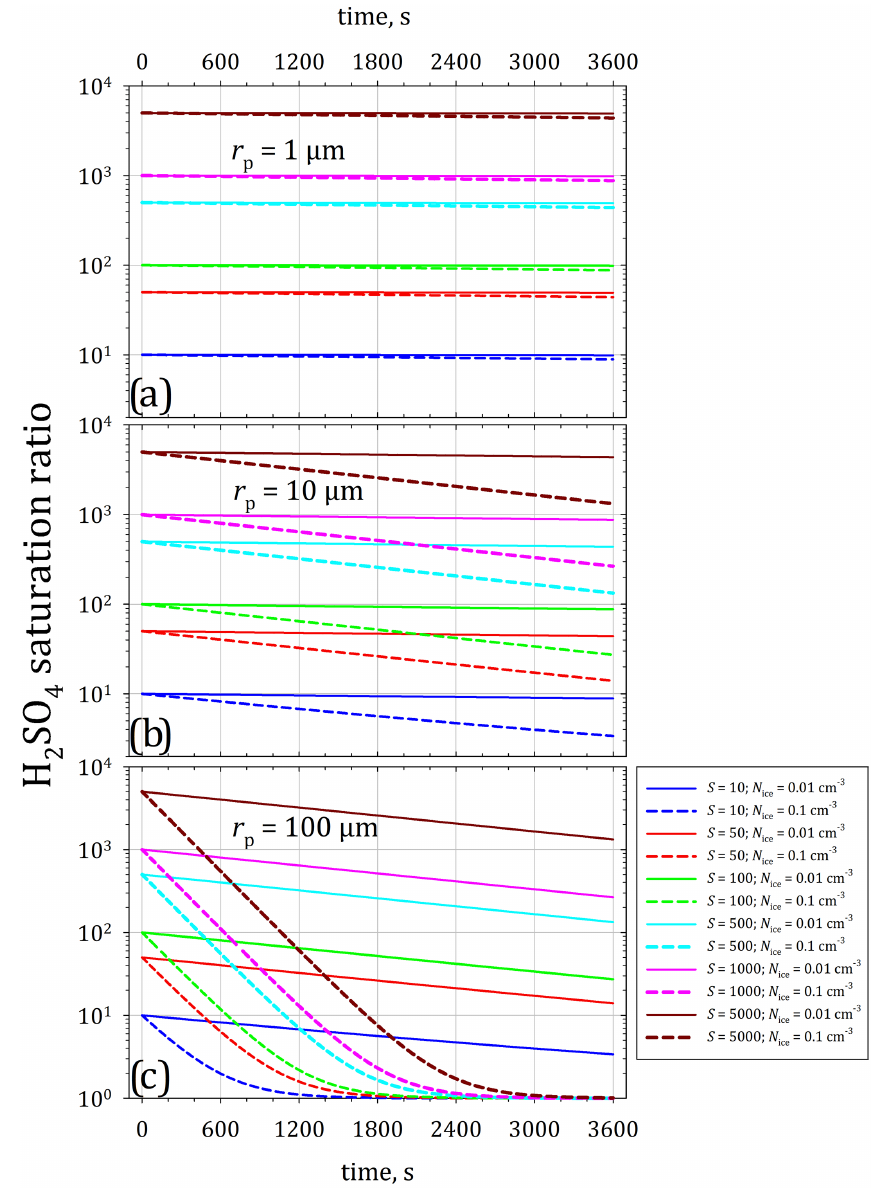
Figure B1. Simulated change in the H 2 SO 4 vapour’s saturation ratio as a function of time due to the presence of entirely H 2 SO 4 -coated ice particle surfaces of various sizes and number concentrations. (a) Particles with radii r p = 1µm, (b) r p = 10µm, (c) r p = 100µm. Overall, this simulation covers a range of integral radii IR ( = r ice · N ice ) from 0.01 to 10µmcm − 3 . Note: a cloud (ice) particle is assumed as coated with H 2 SO 4 (consistent with Bogdan et al., 2006,